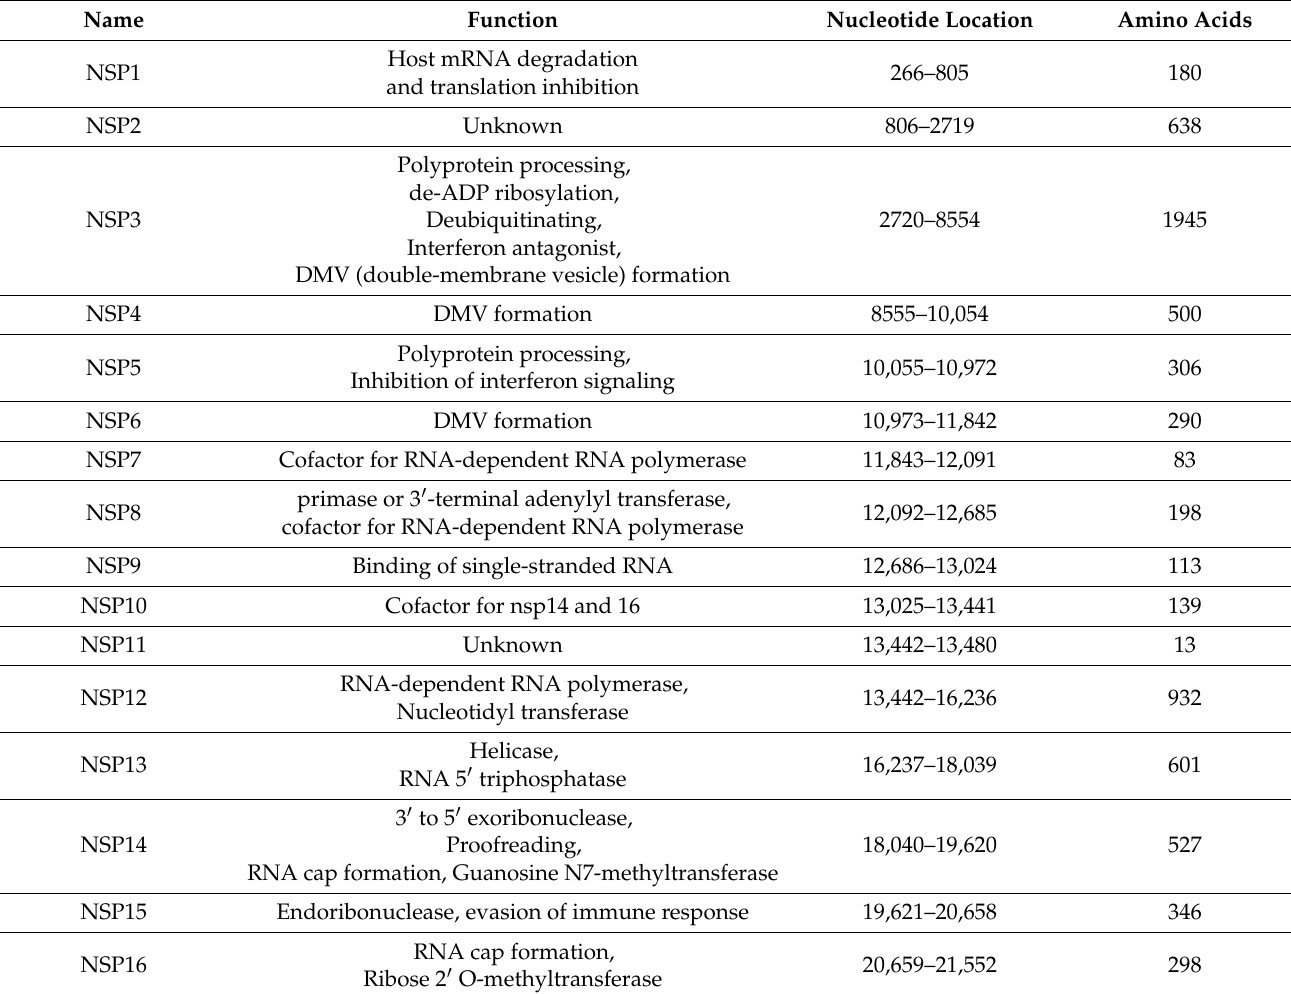
Table 2. Structural and functional details of NSPs of